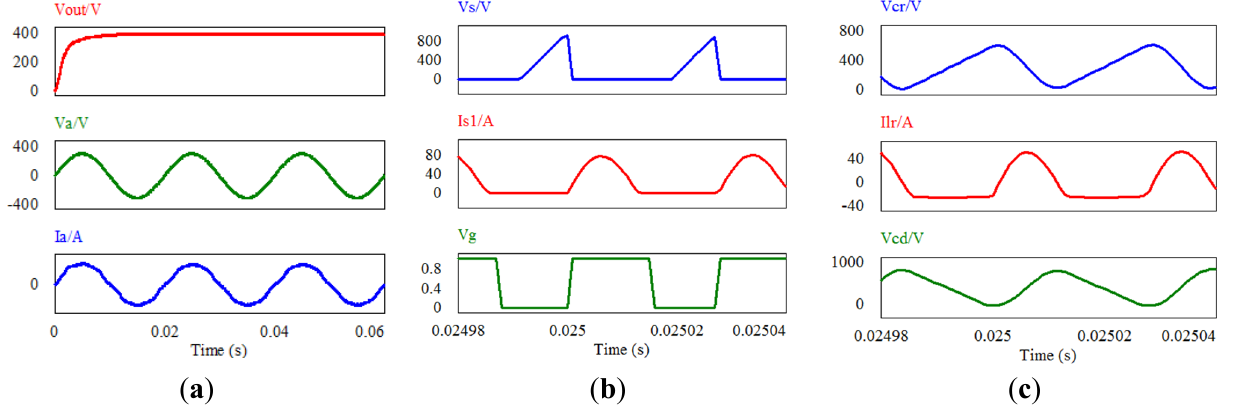
Figure 16. Simulated waveforms under 20-kW maximum output power: ( a ) input current, input and output voltage; ( b ) voltage and current of IGBT; ( c ) voltage of resonant